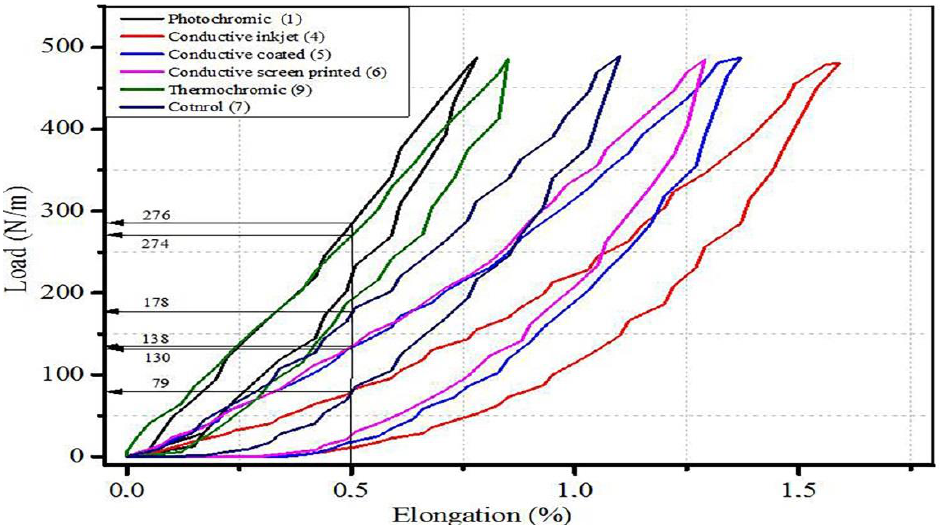
Figure 2. A load – elongation curve of functional fabrics (warp way). These measurements were taken to compare the KES results of different functional fabrics treated with different application methods. They have the same substrate material; polyester fabric with 158 gsm. The load – elongation curve clearly indicates the effects of functional finishing on extensibility.